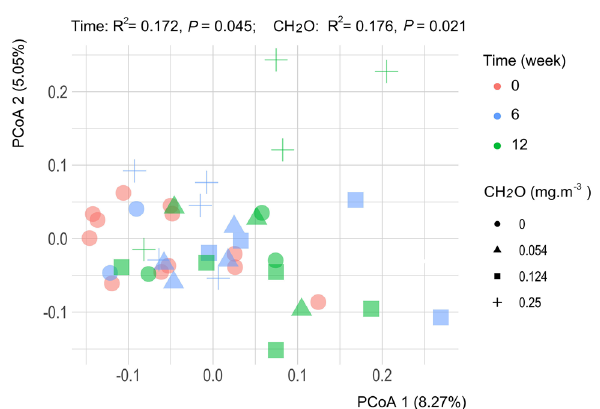
Figure 2. Principal coordinates analysis of bacterial communities based on the Bray–Curtis distance. Permutational multivariate analysis of variance were conducted according to experiment time and CH 2 O levels, respectively. The values of R 2 and P were shown in the